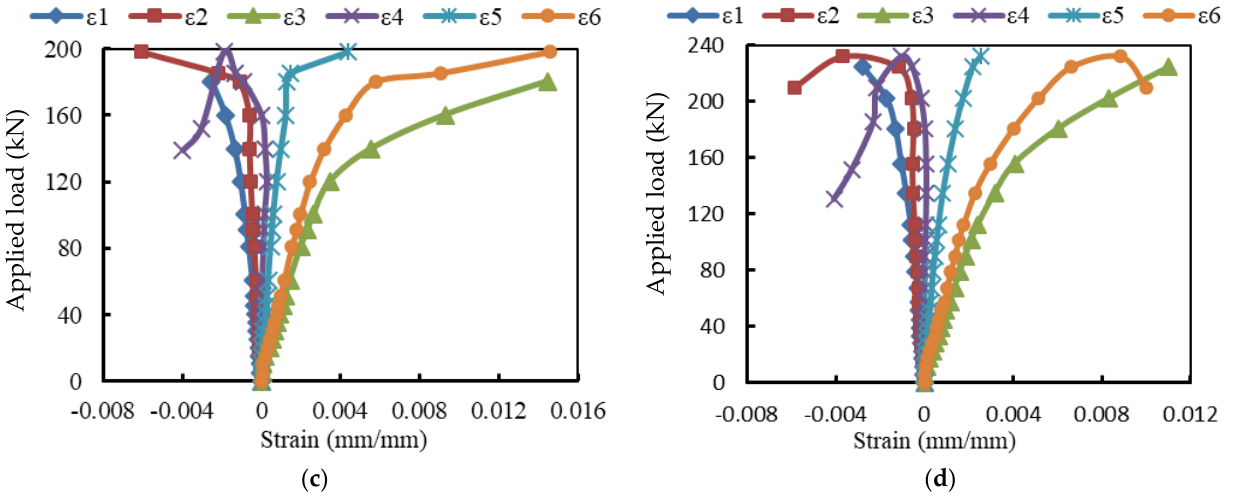
Figure 8. Load-strain relationships at mid-span of the encased beams. ( a ) Beam EG. ( b ) Beam EGS. ( c ) Beam EGW. ( d ) Beam EGSW.